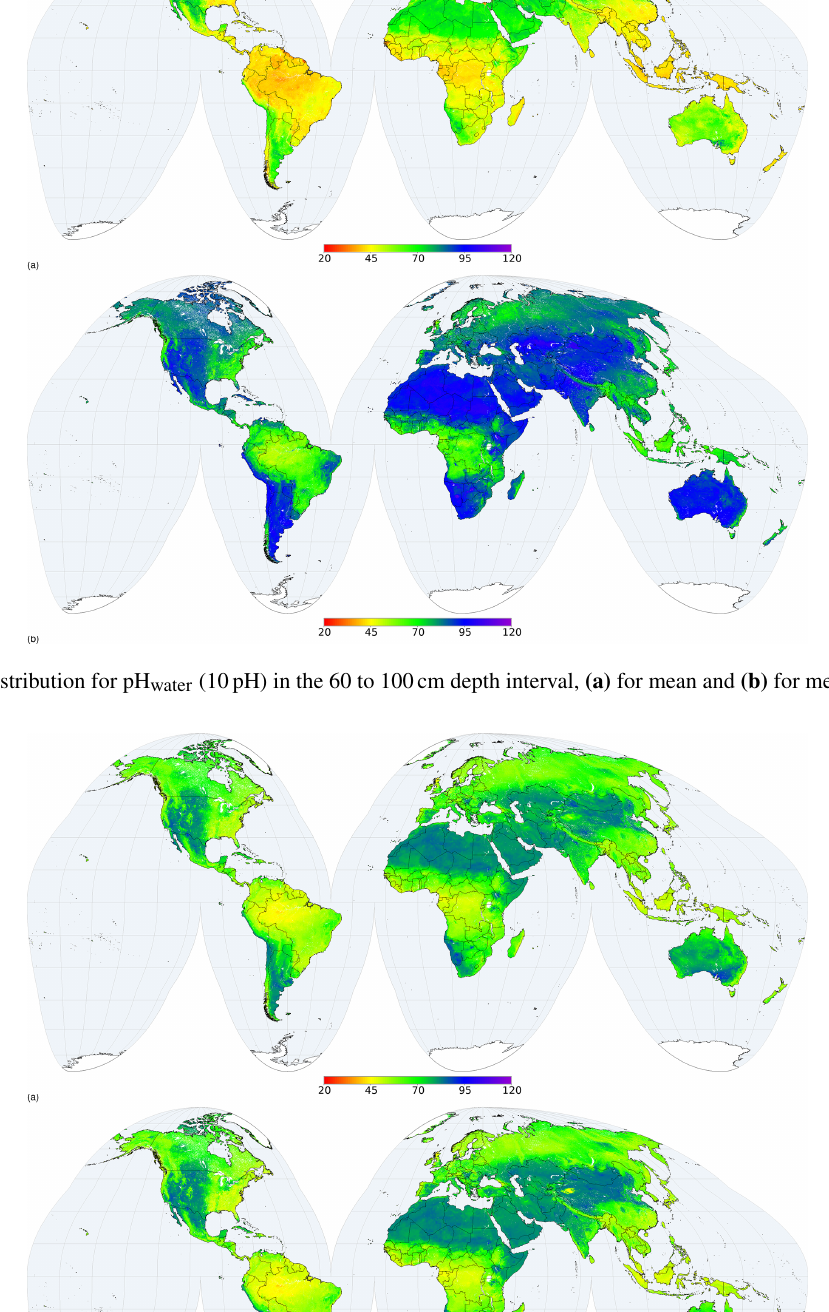
https://doi.org/10.5194/soil-7-217-2021 SOIL, 7, 217–240,